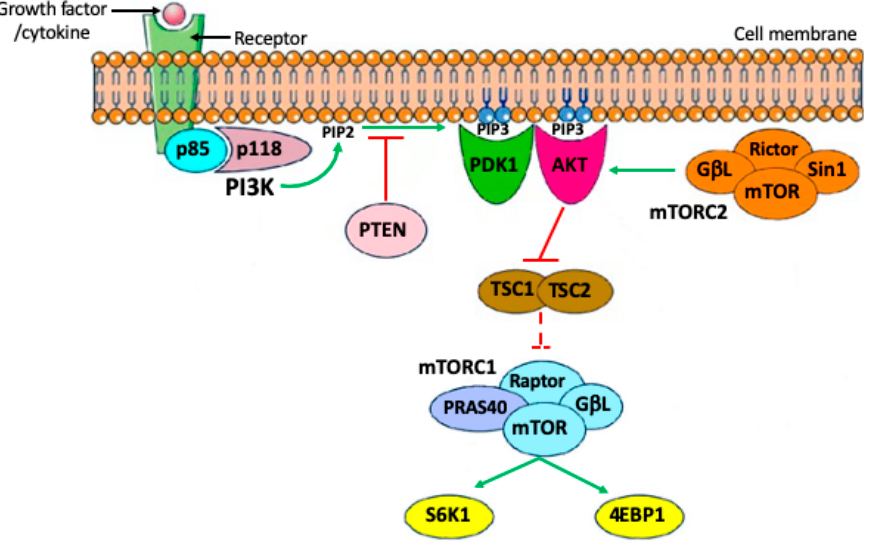
Figure 1. Simplified PI3K/PTEN/AKT signaling pathways discussed in the present